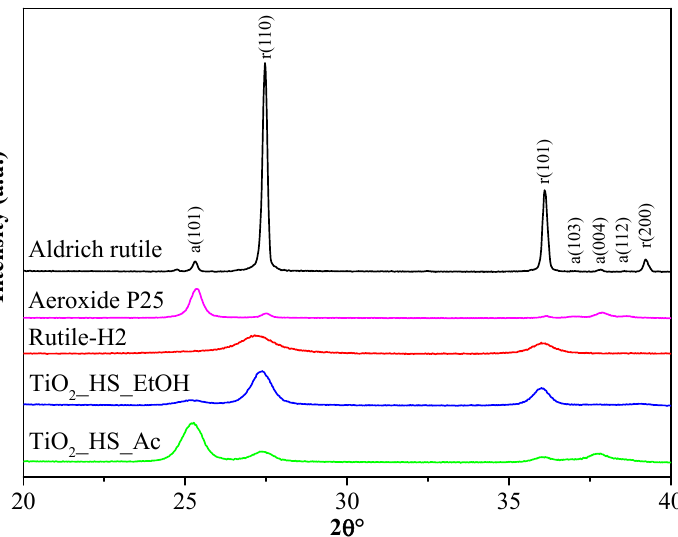
Figure 1. X-ray diffraction patterns of home-made and reference titanium dioxides.